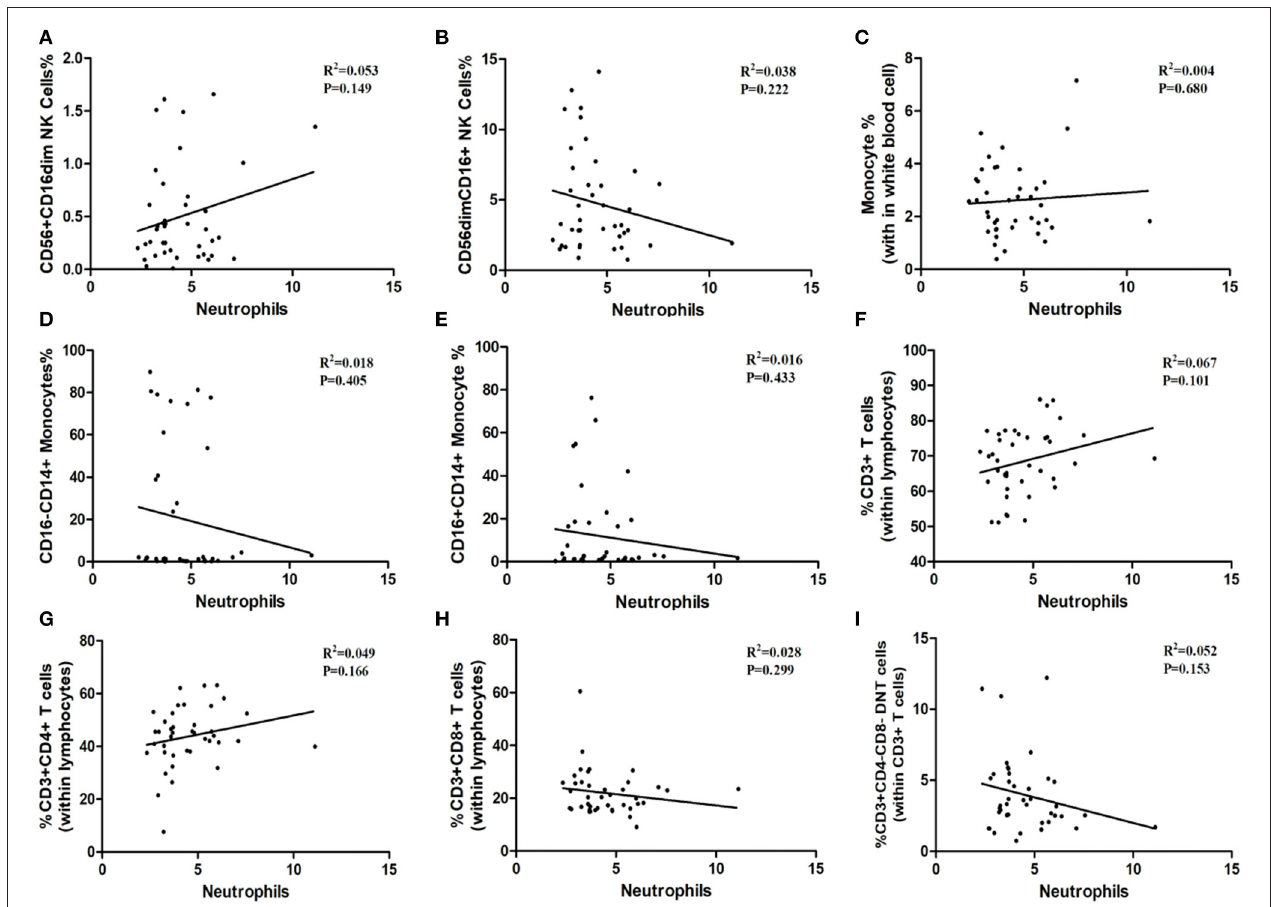
FIGURE 7 | The correlation between immune cells and neutrophils. (A) CD56 + CD16dim NK cells. (B) CD56 dim CD16 + NK cells. (C) Monocytes. (D) CD16 − CD14 + Monocytes. (E) CD16 + CD14 + Monocytes. (F) CD3 + T-Cells. (G) CD3 + CD4 + T-Cells. (H) CD3 + CD8 + T-Cells. (I) CD3 + CD4 − CD8 − T cells.